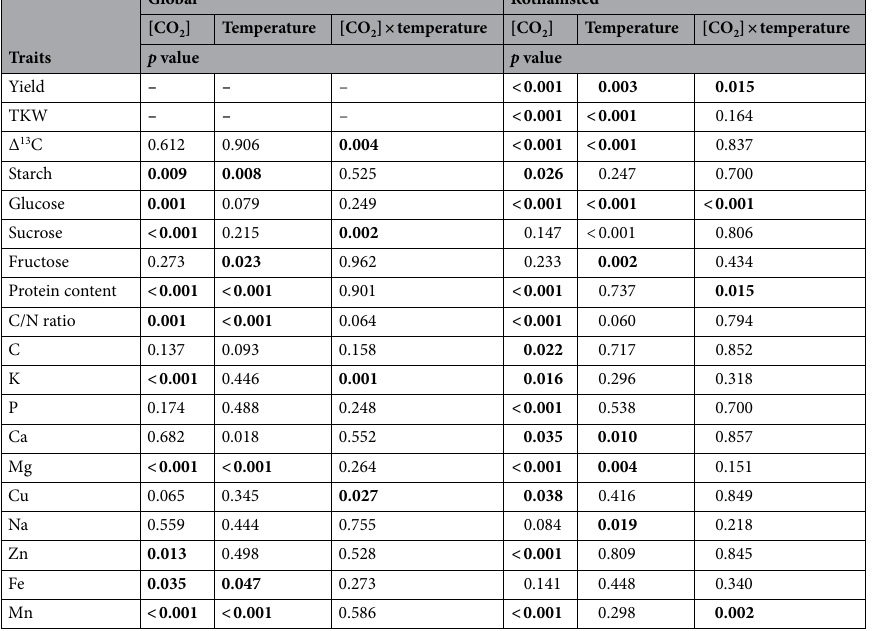
Table 6. Multifactor analysis of variance (ANOVA). The calculation of p values in based on multifactor analysis of variance ANOVA. Values in bold indicate significance ( p < 0.05). ‘–’ indicates unavailable p value.